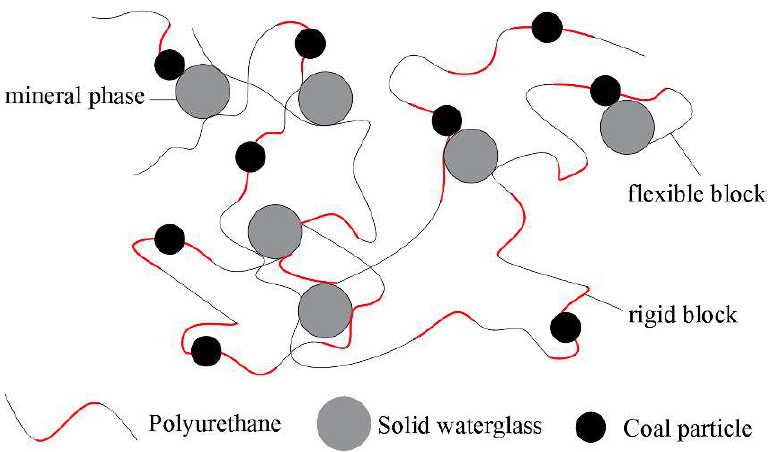
Figure 24. Bonding mechanism between sodium silicate / polyurethane adhesive and coal [112].